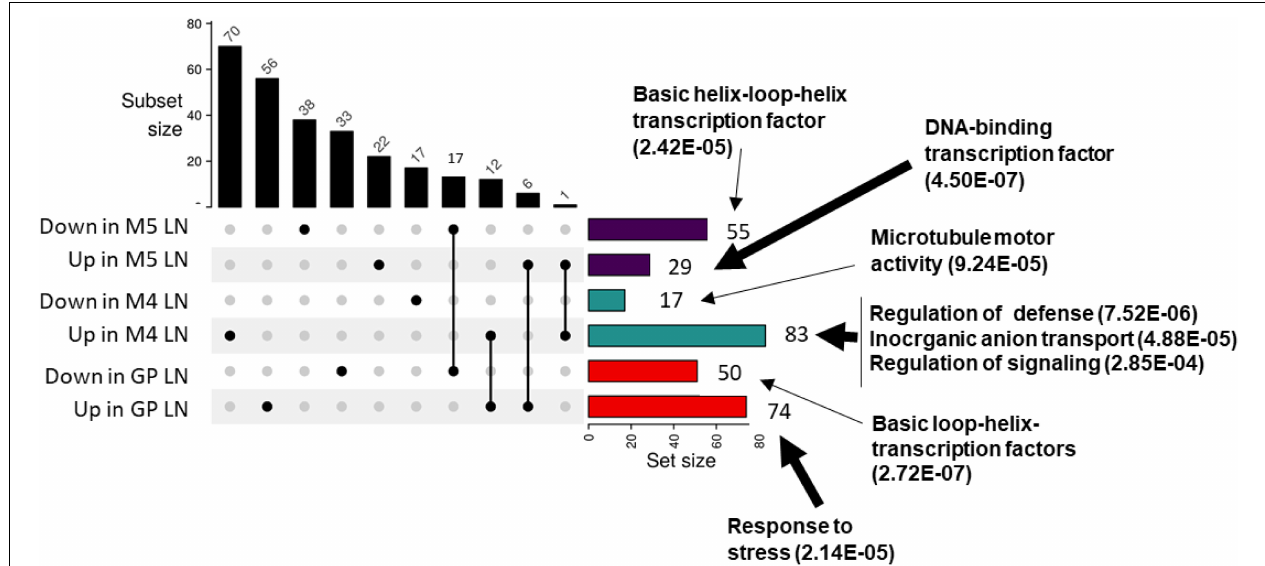
FIGURE 5 | Differentially regulated genes under LN and HN in GP, M4, and M5. Plants were grown for 14 days under LN or HN then leaves were frozen under liquid nitrogen. RNA was extracted from leaves and RNAseq was performed as indicated in “Materials and Methods” section. Upset plot for overlapping up and down differentially expressed genes in M4, M5, and GP barley genotypes under LN or HN. The number of genes in each category is indicated on top of each bar. Functional categories overrepresented in the set of genes are indicated next to the arrows (geneontology.org). Thick arrows indicate up-regulated genes, thin arrows indicate down-regulated